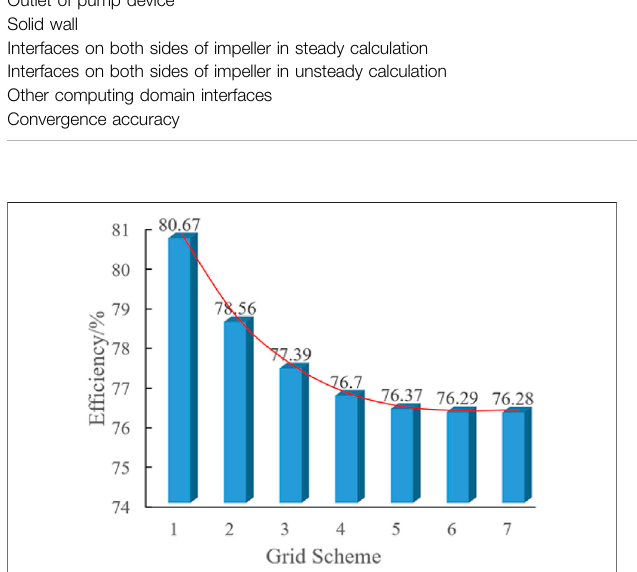
FIGURE 2 | Ef fi ciency comparison of pump devices under different grid schemes.